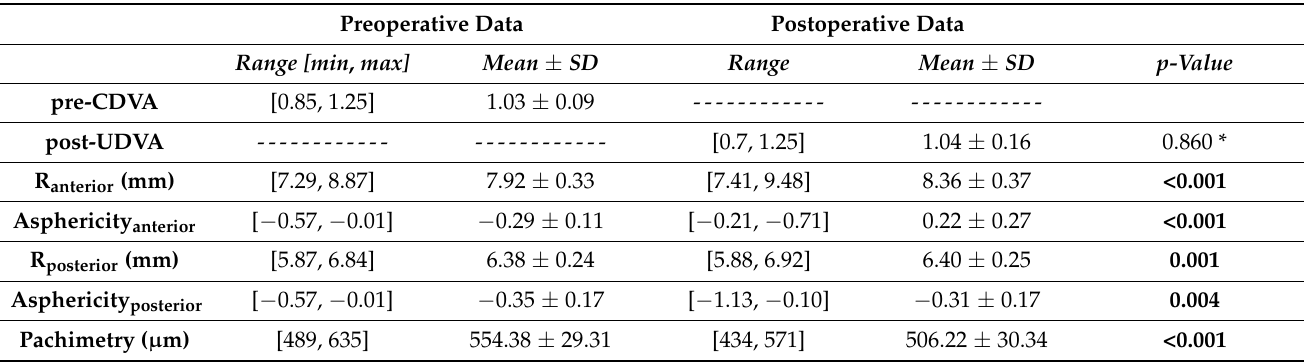
Table 1. Comparison of preoperative and postoperative LASIK values. The ranges, mean and standard deviation in visual acuity, corneal radii, asphericity and pachymetry are presented, as well as the result of the statistical analysis ( p -value). Statistically significant values are highlighted in bold.